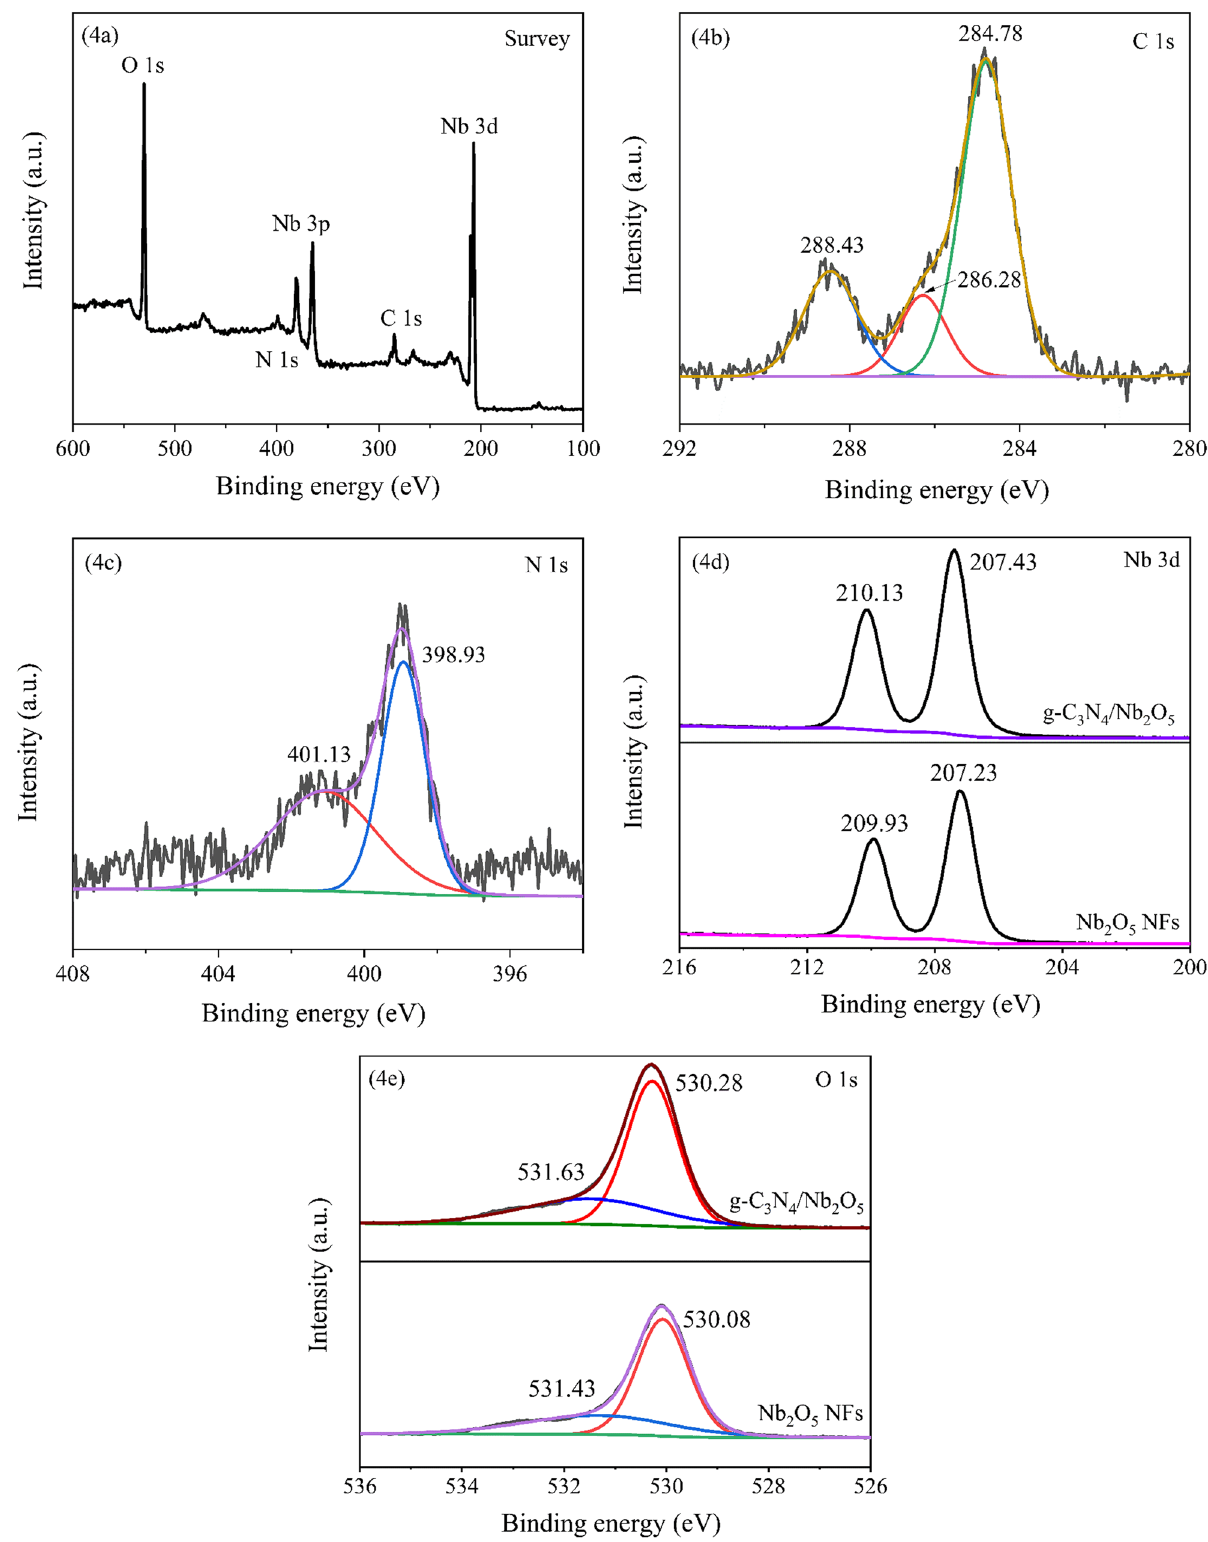
Figure 4. ( a ) XPS survey spectrum and high resolution XPS spectra of ( b ) C 1s, ( c ) N 1s, ( d ) Nb 3d and ( e ) O 1s in g-C 3 N 4 /Nb 2 O 5